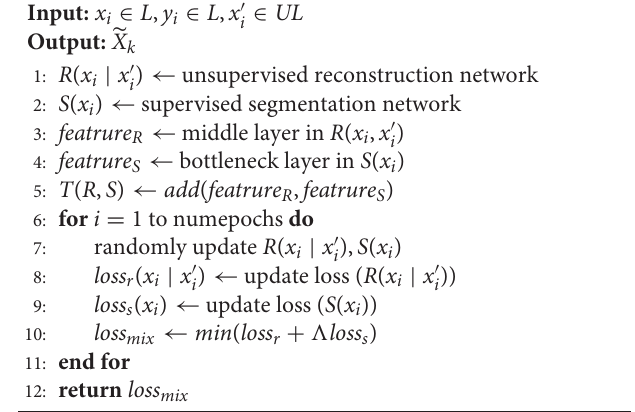
Algorithm 1 COL-Net Algorithm